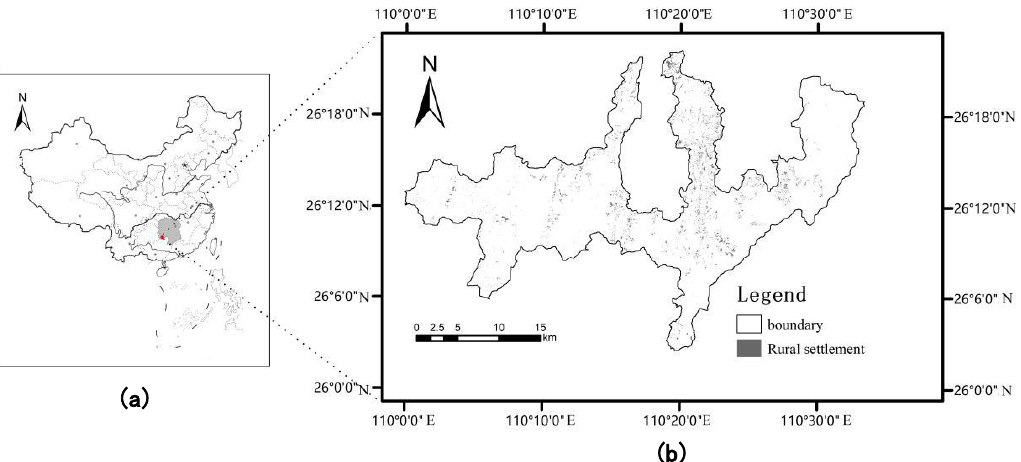
Figure 1. ( a ) Geographic location of the study area in China and ( b ) distribution of rural settlements in the study area.